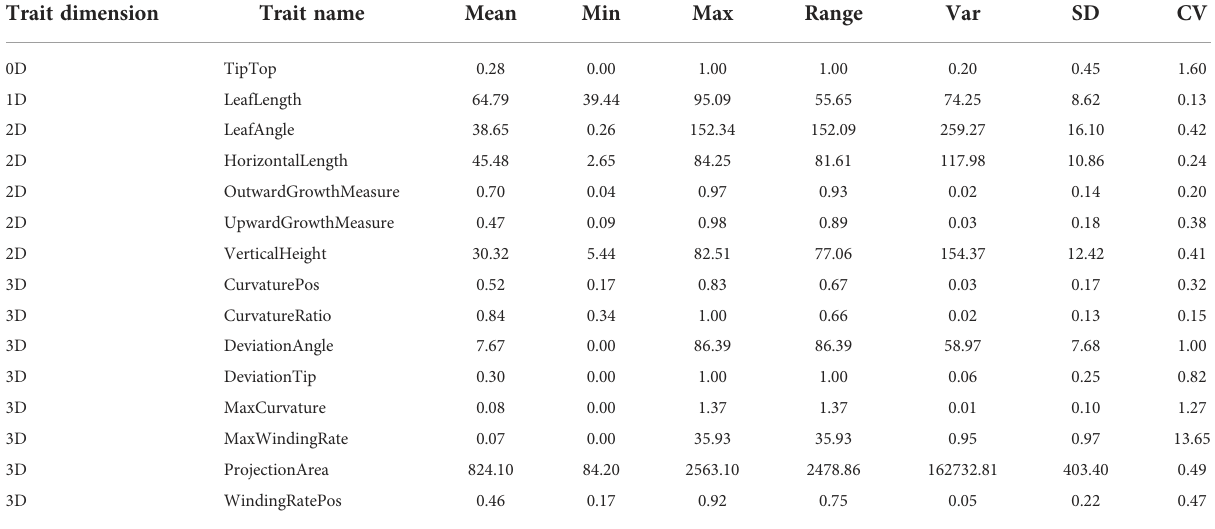
TABLE 1 Descriptive statistical analysis results of 15 maize leaf midrib curve traits. Trait